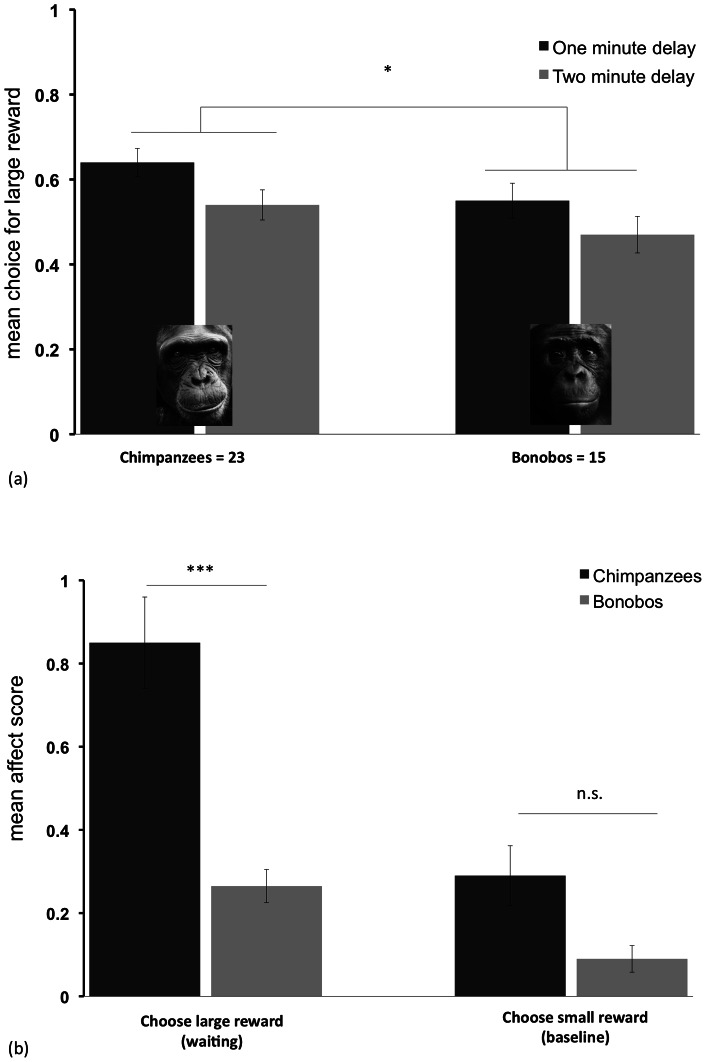
Temporal preferences and affective responses in study 1.a) Chimpanzees and bonobos chose between a smaller, immediate reward and a larger reward delayed by one or two minutes across conditions. b) Composite affect scores while waiting versus not waiting; a higher score indicates a more intense reaction with the production of more target behaviors (scratching, vocalizing, and banging). Error bars represent standard error of means.